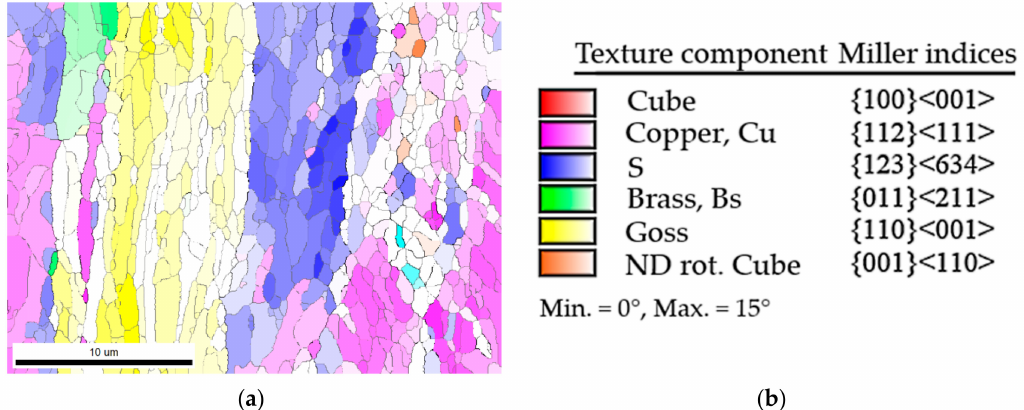
Figure 2. ( a ) Reconstructed subgrain structure for the as-deformed state of the commercial purity aluminium (CP Al) material. ( b ) Colour coding for the di ff erent texture orientations considered in this